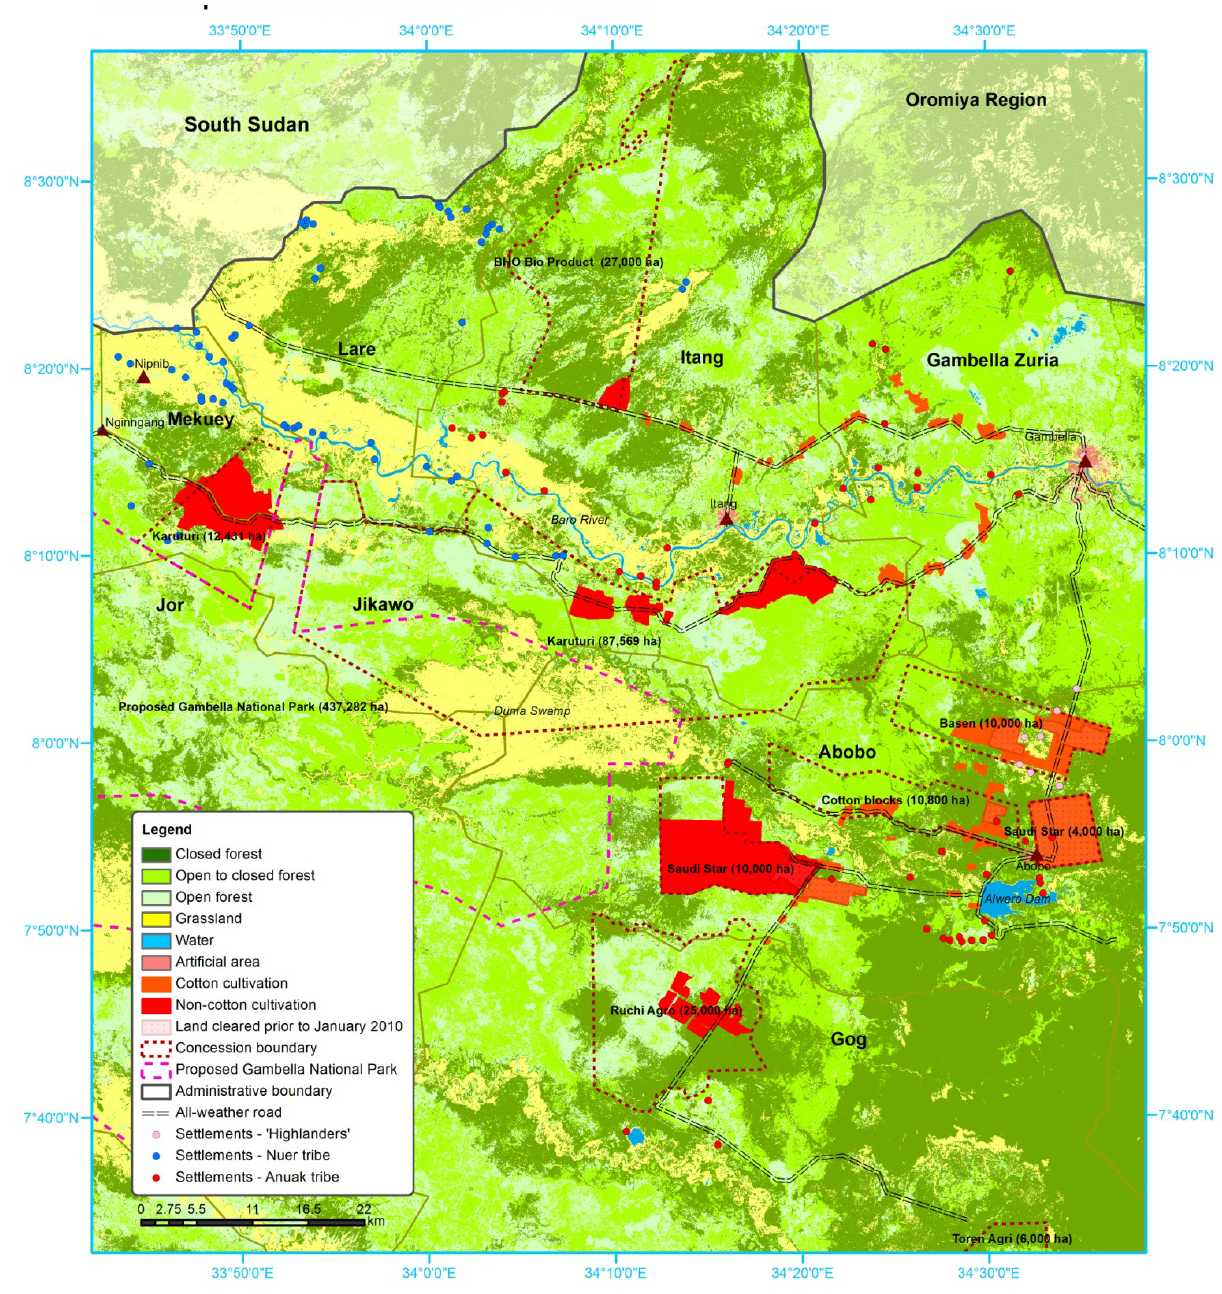
Figure 2. Land use within Lower Baro-Akobo River Basin. Source: Author’s representation, based on NASA Landsat 5 satellite imagery (30 m resolution), GeoEye, field research, EWCA coordinates, and AILAA Provisional Land Lease